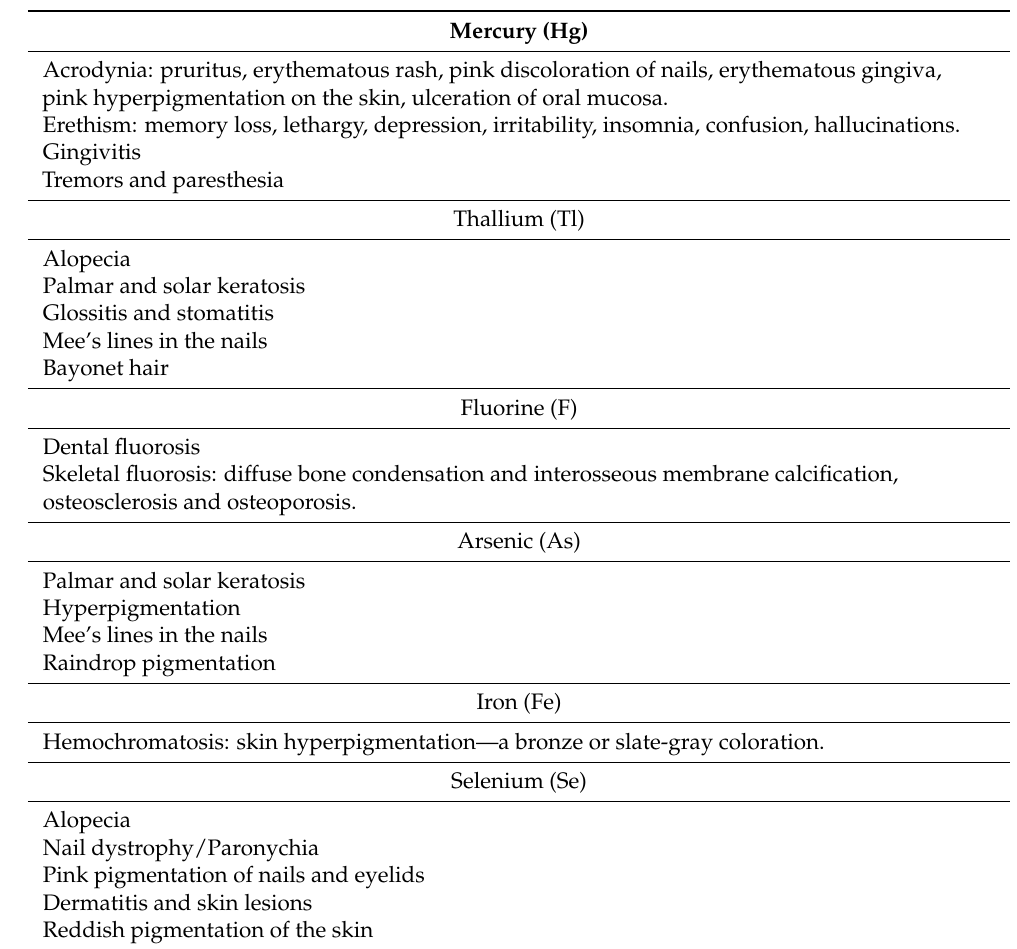
Table 1. Signs and symptoms associated with poisoning by the addressed chemical